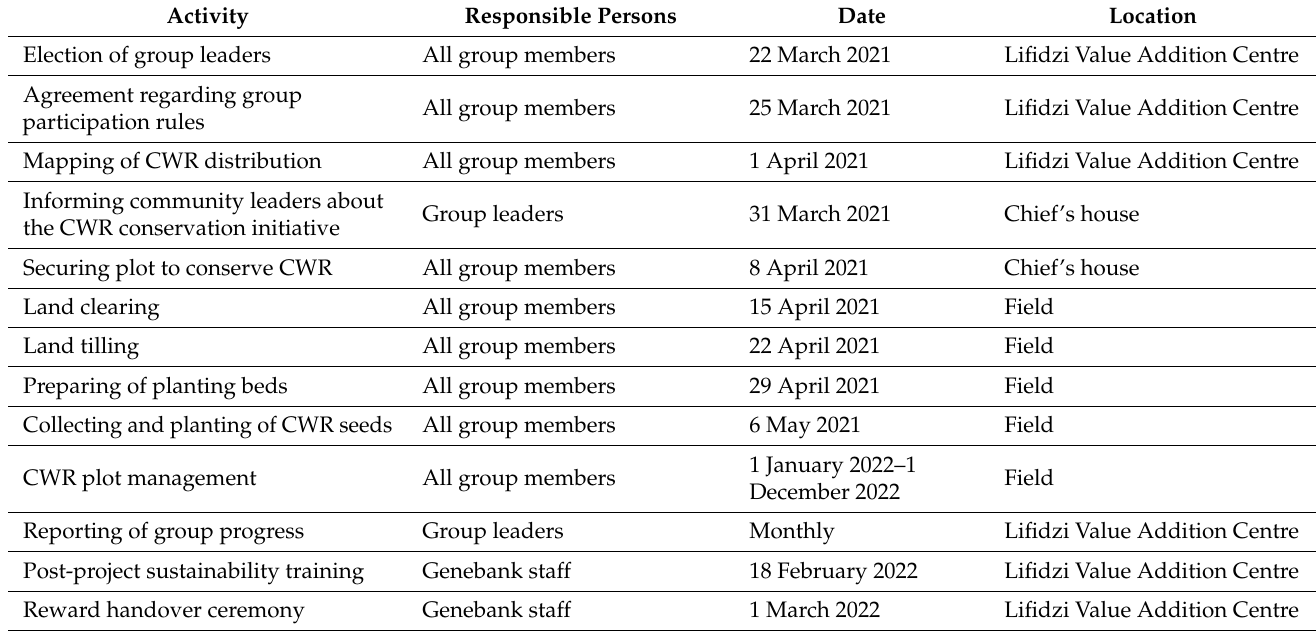
Table 1. Workplan example for CWR conservation activities applied in Salima